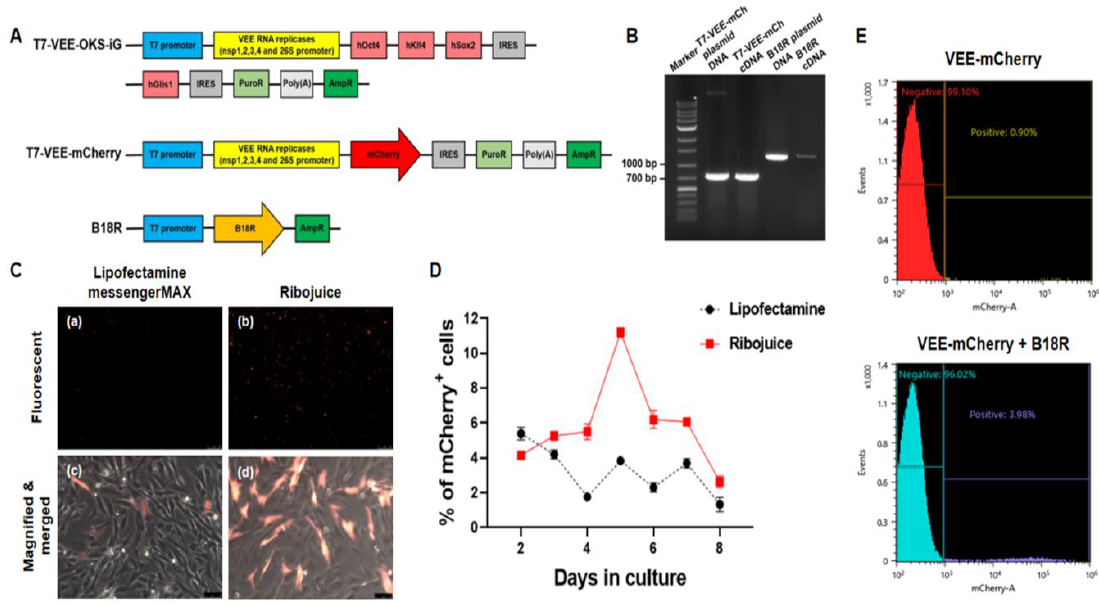
Figure 2. Construction of synthetic mRNAs and the measurement of transfection efficiencies. ( A ) Maps of T7-VEE-OKS-iG , T7-VEE-mCherry, and B18R vectors. Venezuelan equine encephalitis (VEE) RNA replicases are represented as bright yellow boxes. ( B ) Confirmation of plasmid DNA (control), and polymerase chain reaction (PCR) products (complementary DNA; cDNA) from RNA templates by reverse transcription (RT)-PCR analysis. ( C ) Representative images of T7-VEE-mCherry RNA-transfected canine fibroblasts comparing Lipofectamine messengerMAX and Ribojuice tranfection reagents. Scale bars = 250 μm for (a, b) and 75 μm for (c, d). ( D ) Percentage of mCherry + transfected cells using the Lipofectamine MessengerMAX or RiboJuice transfection reagent. The value represents mean ± SEM. ( E ) Representative flow cytometry histogram showing the mCherry fluorescence of the mCherry + transfected cell population. Transfected with VEE RNA alone (upper); co-transfected with the T7-VEE-mCherry RNA replicon and B18R (bottom). All the experiments were replicated at least three times.